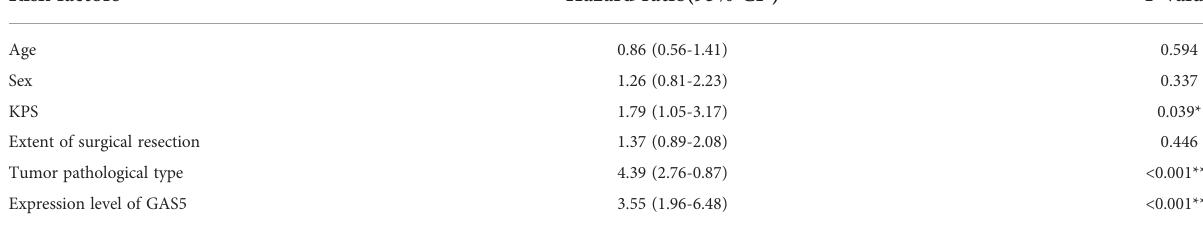
TABLE 2 Reasons for hazard ratio of risk